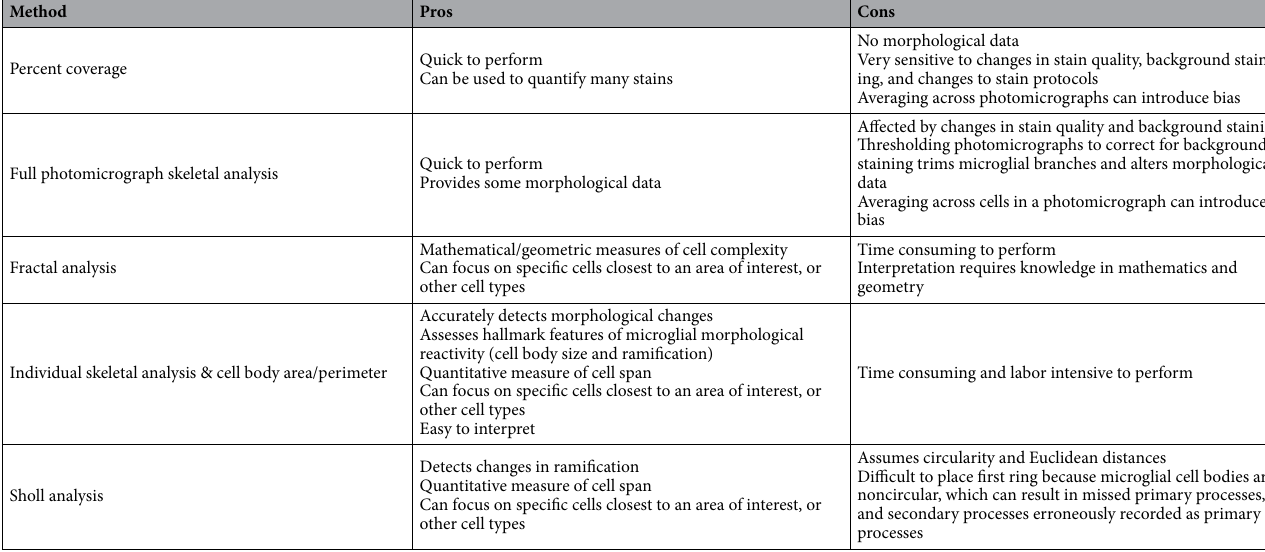
Table 1. Summary of comparisons among contemporary ImageJ-based methods used for quantifying microglial